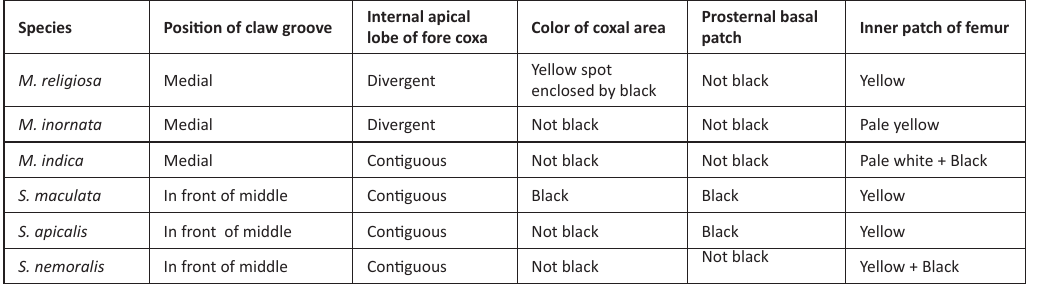
Table 1. Morphological differences among related species of Mantis and Statilia